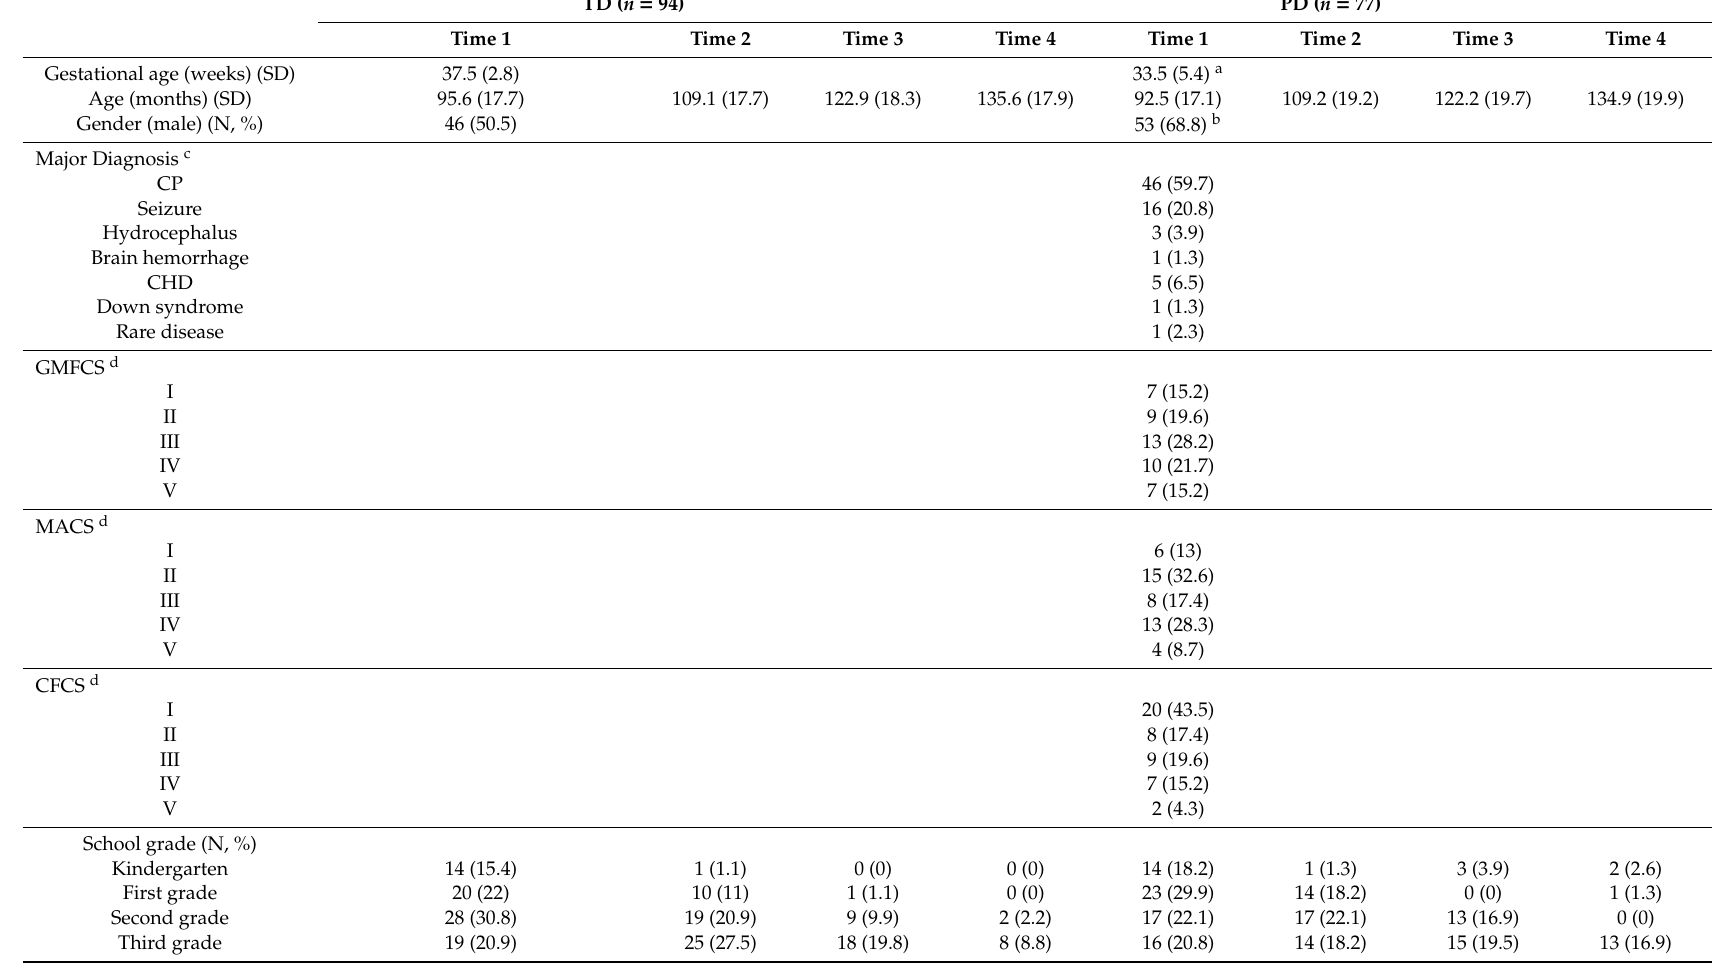
Table 1. The demographic data for children with typical development (TD) and children with physical disabilities